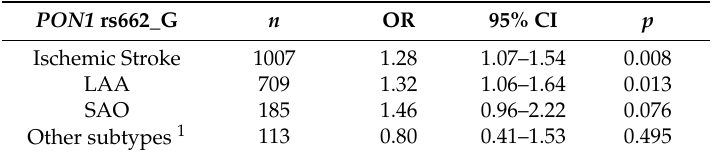
Table 2. Association of PON1 rs662_G with ischemic stroke and its subtypes. PON1 rs662_G n OR 95%